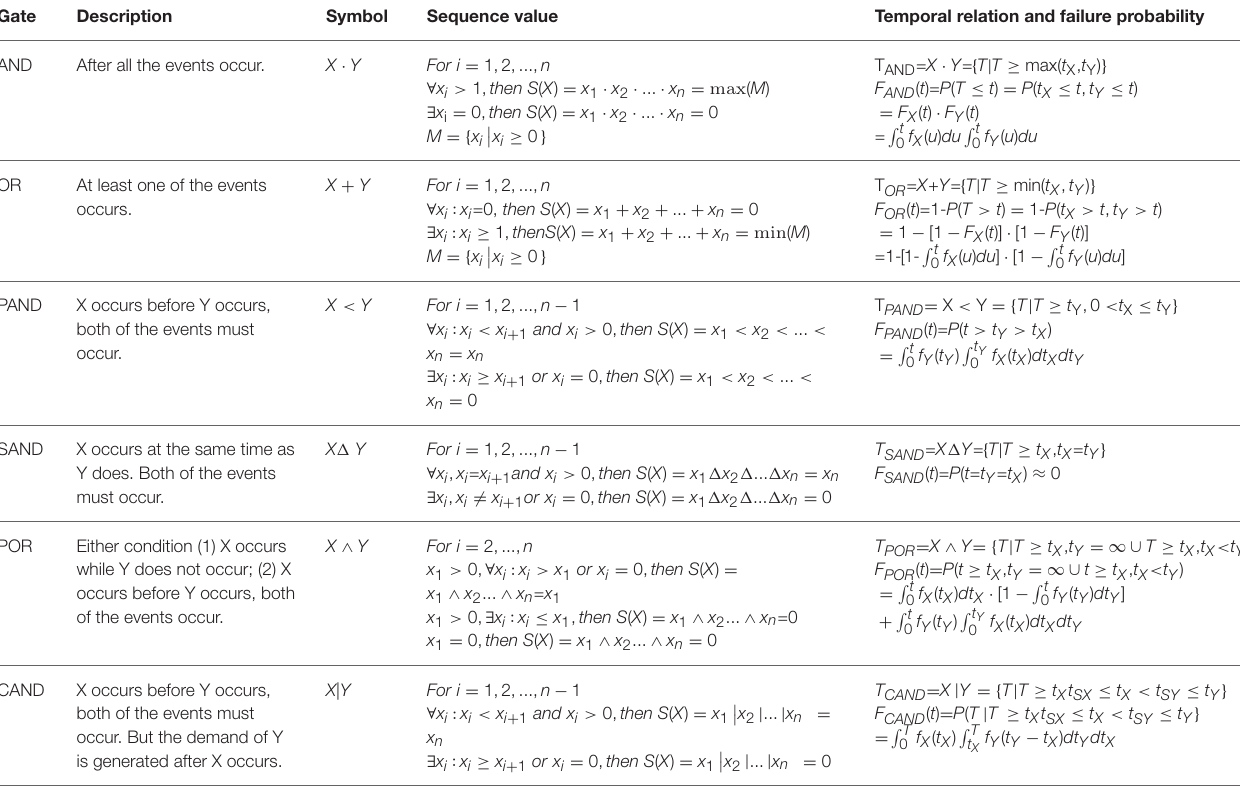
Temporal relation and failure